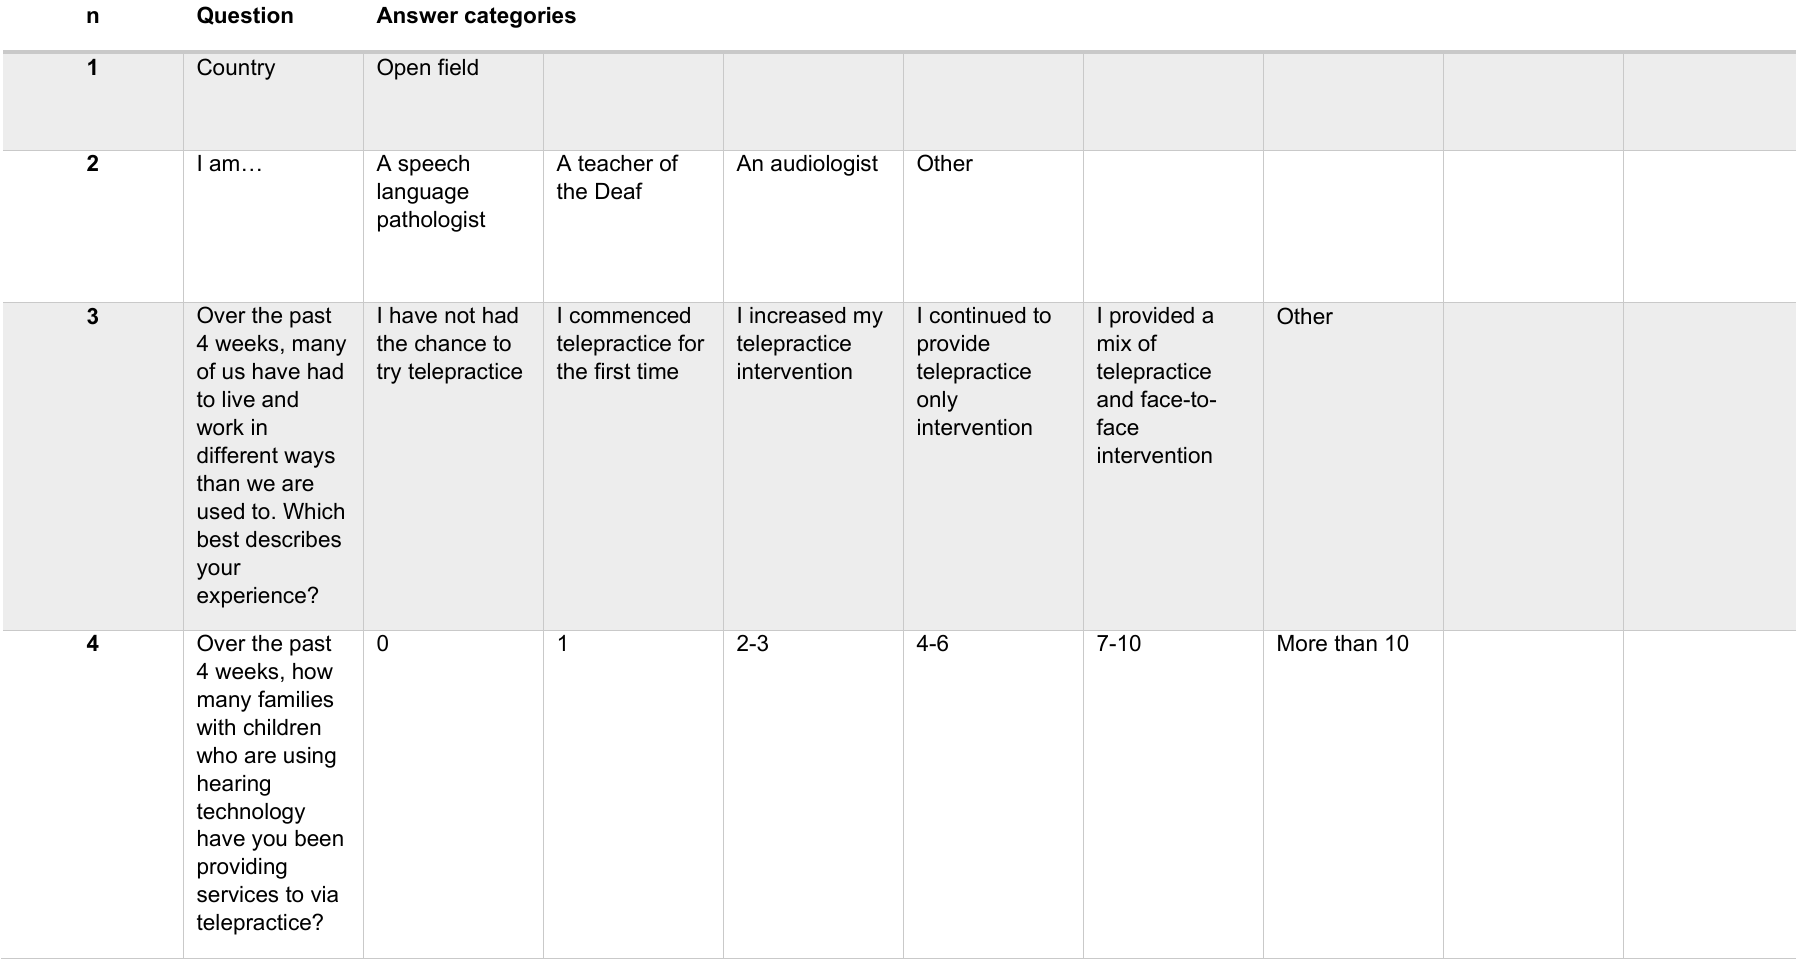
Table A2 Survey 2 Questions and Answer